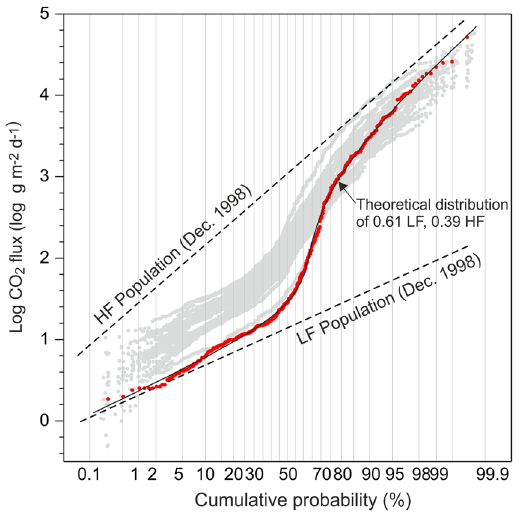
Figure 3. Log probability plot of the soil CO 2 fluxes. Grey dots show log CO 2 flux data statistical distribution of all the surveys. As example are reported, the December 1998 dataset with red dots, the partitioned population (HF and LF populations) for this dataset using Sinclair method 71 (see Methods) with the dashed lines, and the theoretical distribution resulting from the combination of the HF and LF populations in the proportion 61% LF and 39% HF with the solid